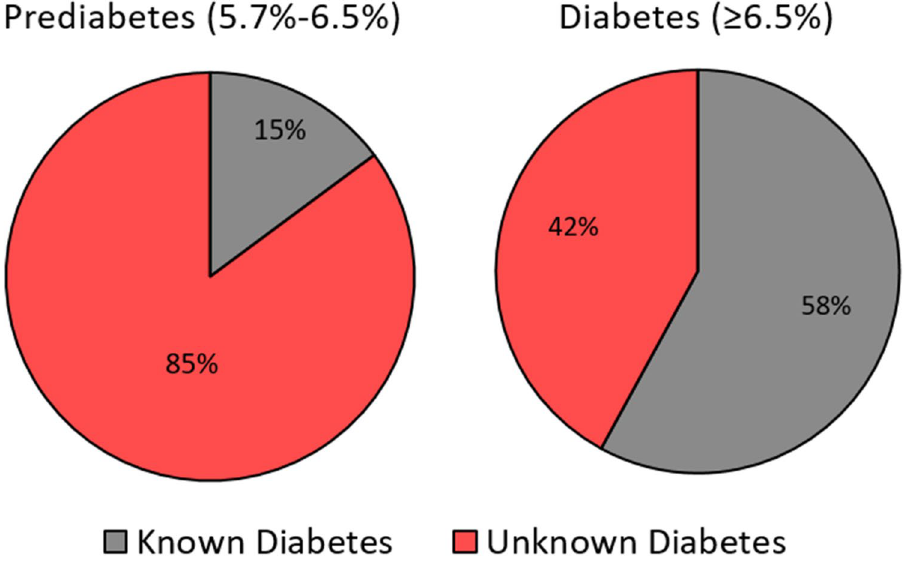
Figure 1. Proportion of patient with known diabetes with HgbA1c levels in the prediabetes and diabetes range.